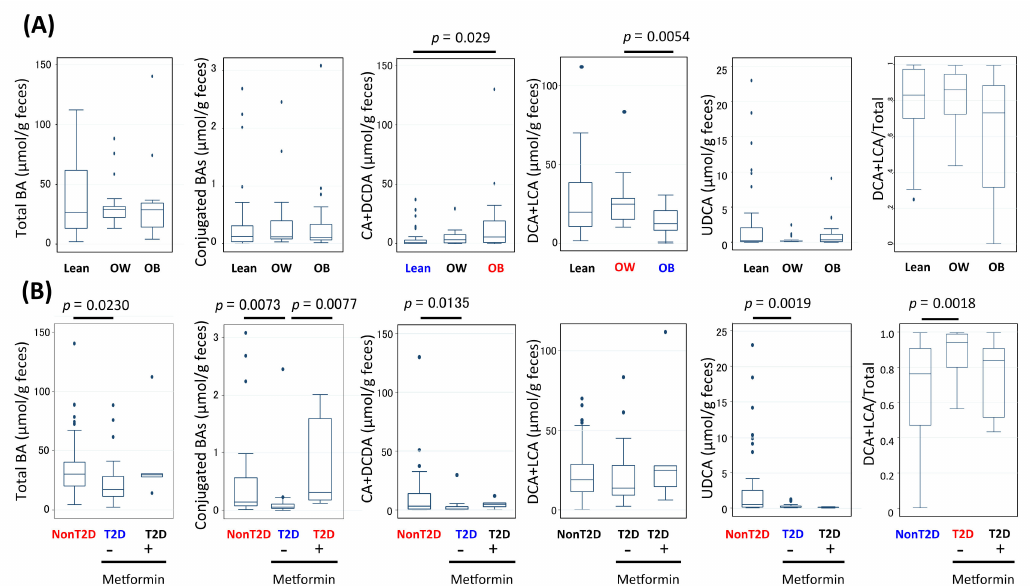
Figure 4. Comparison of fecal BA concentrations between different BMI groups ( A ) and among the non-T2D group and metformin-treated and non-treated T2D groups ( B ). The distribution of each BA group concentration ( µ mol/g dry feces) was graphed in box plots. The statistical difference between groups was calculated by the pairwise Wilcoxon rank-sum with Holm adjustment and p value lower than 0.05 was denoted.